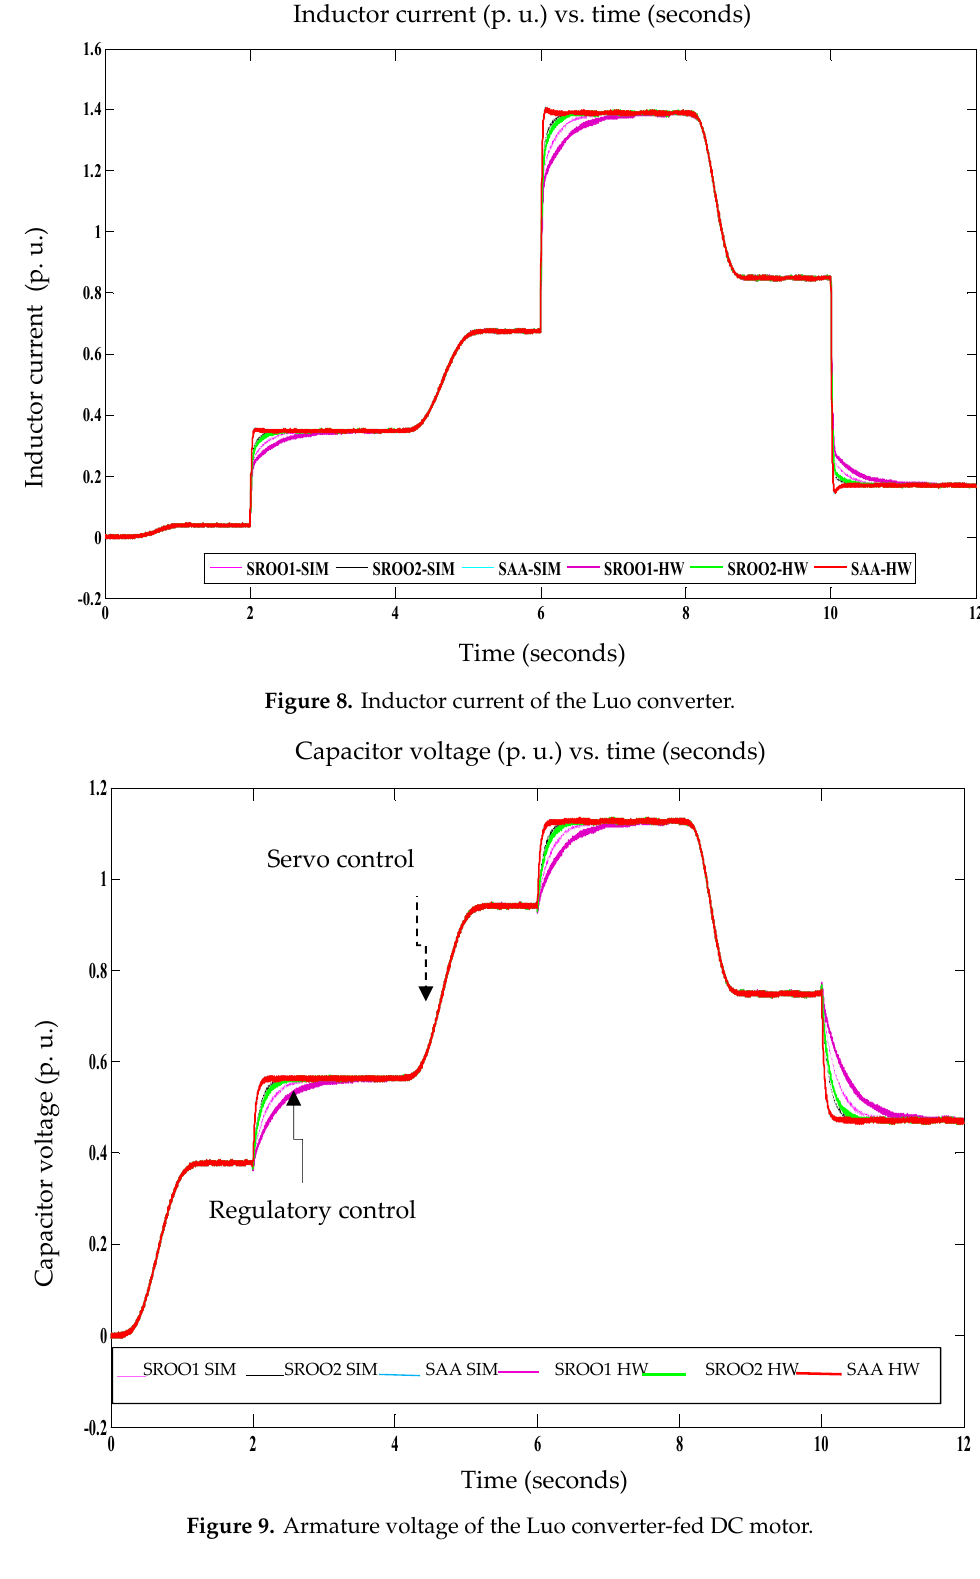
Figure 7. Speed reference profile.